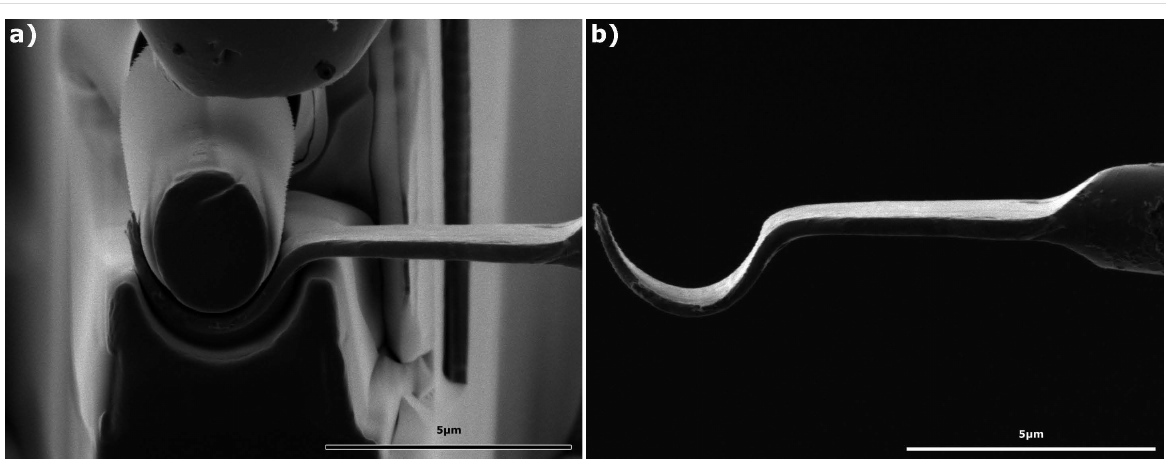
Nevertheless a smooth and clear geometry is reproduced (Figure